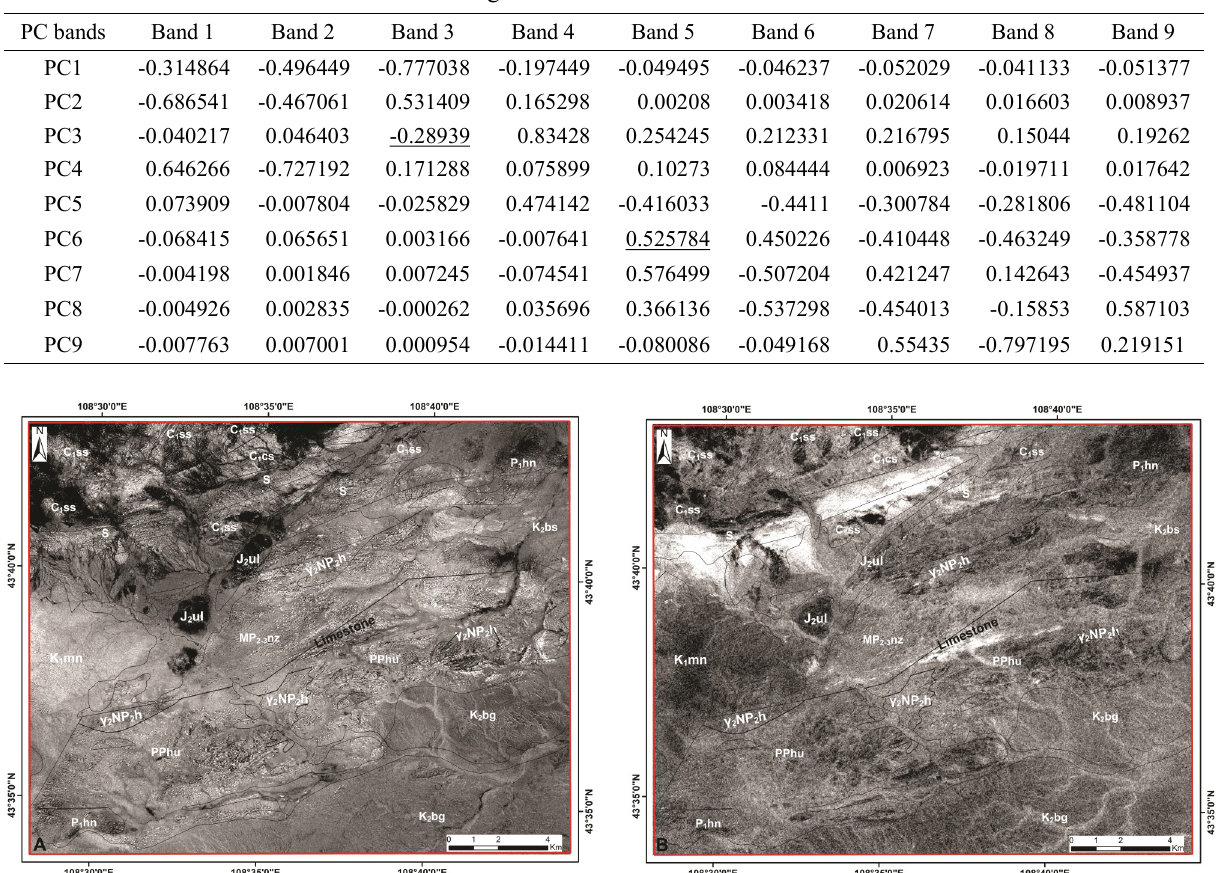
Table 4. The matrix of eigenvectors for PCA calculated from ASTER